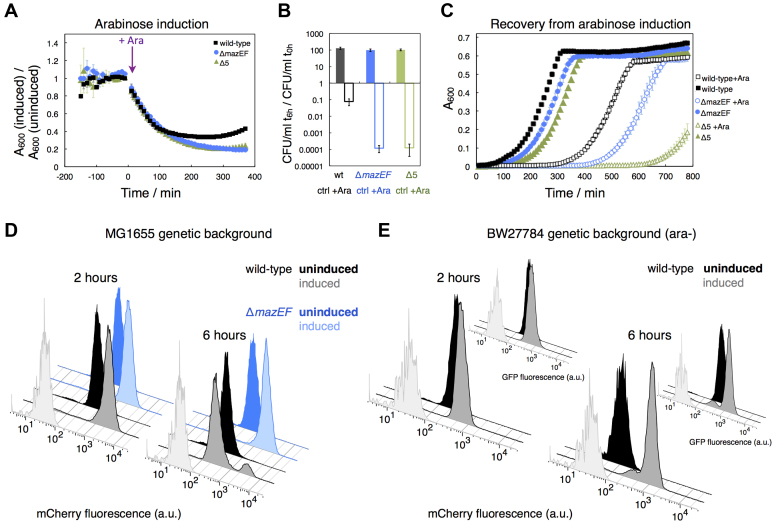
Influence of the antitoxin MazE on growth and constitutive reporter fluorescence during mazF overexpression. (A) We monitored growth of strain MG1655 (black), and isogenic strains ΔmazEF (blue) and Δ5 (five deleted TA loci) (green) harboring plasmids pBAD-mazF and pZS*-mCherry. 0.1% Ara was added to one half of exponentially growing cultures to induce mazF overexpression; the uninduced half served as a control. Growth was measured as absorbance at 600 nm (A600), and plotted is the ratio of the A600 measurements of induced cultures and uninduced (control) cultures, calculated per replicate. (B) We calculated the changes in CFU (colony-forming units) after 6 h in induced (empty bars) and uninduced cultures (filled bars) relative to the exponential cultures. Both mutant strains, ΔmazEF (empty blue bar) and Δ5 (empty green bar), exhibited lower CFU count compared to the wild-type strain (empty black bar) after 6 h of arabinose induction. (C) Six hours after arabinose induction, induced and uninduced cultures were washed, and allowed to recover in fresh media. We defined the period to exit the stress-phase as time required for bacterial populations to reach their maximum growth rate relative to the exit of uninduced cultures. The wild-type strain recovered from stress after 4.5 hours, the isogenic ΔmazEF and Δ5 strains recovered after 5.6 hours and more than 9 hours, respectively (N = 3 replicates, except two replicates for induced Δ5 cultures). (D) We analyzed the effect of mazF overexpression on constitutive fluorescence encoded on plasmid pZS*-mCherry using flow cytometry. The results obtained for uninduced cultures are depicted in black and blue, and induced cultures in gray and light blue for the wild-type and ΔmazEF strain, respectively. Two hours after arabinose induction, induced populations of the wild-type and ΔmazEF strains exhibited increased fluorescence levels. After 6 h, induced populations of the wild-type strain exhibited bimodal distribution of mCherry fluorescence. Here plotted is one replicate per genotype, originating from the same exponential culture. Light grey distributions in panels (D) and (E) depict measurements of the reporterless strains MG1655 and BW27784, respectively, harboring plasmid pBAD-mazF. (E) Flow cytometry analysis of strain TB212, a BW27784 derivative deficient in L-arabinose metabolism, with a chromosomally encoded constitutive mCherry reporter, harboring pZS*-612 with a constitutive gfp reporter gene devoid of ACA sites. Two hours after induction of mazF expression, populations exhibited increased levels of mCherry and GFP fluorescence. After 6 h, bimodal patterns of mCherry fluorescence were detected, which correlate with the bimodal patterns of GFP fluorescence. Here, one replicate is presented, for further results see Supplementary Figure S7.